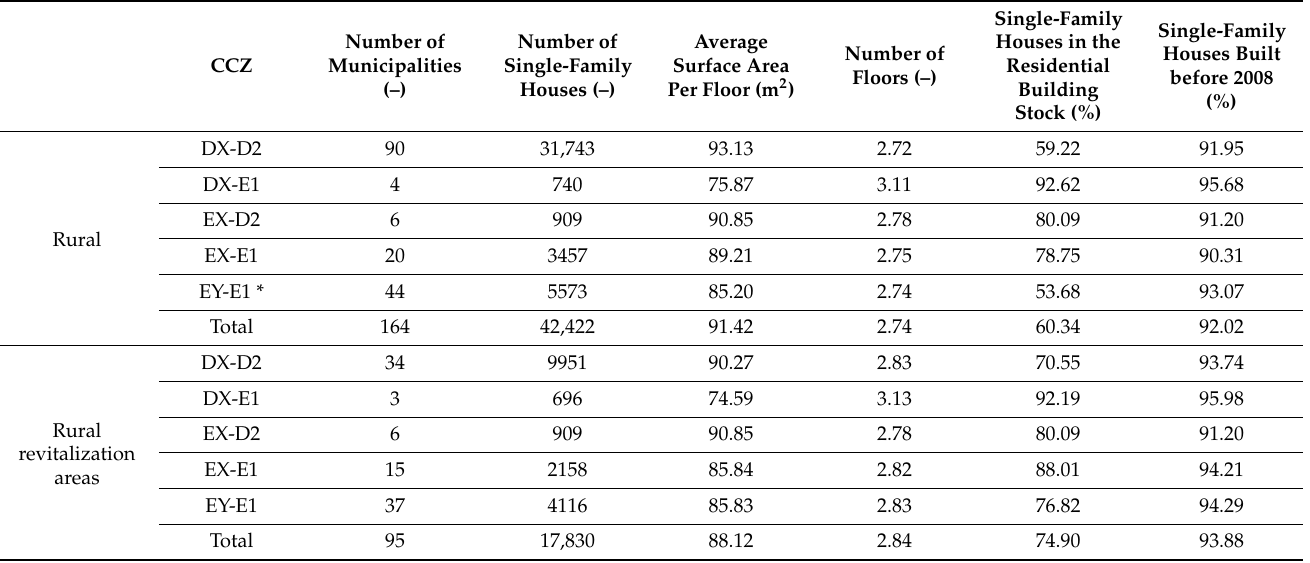
Table 1. Main characteristics of the single-family houses in the residential building stock in La Rioja, both rural and rural revitalization areas, by